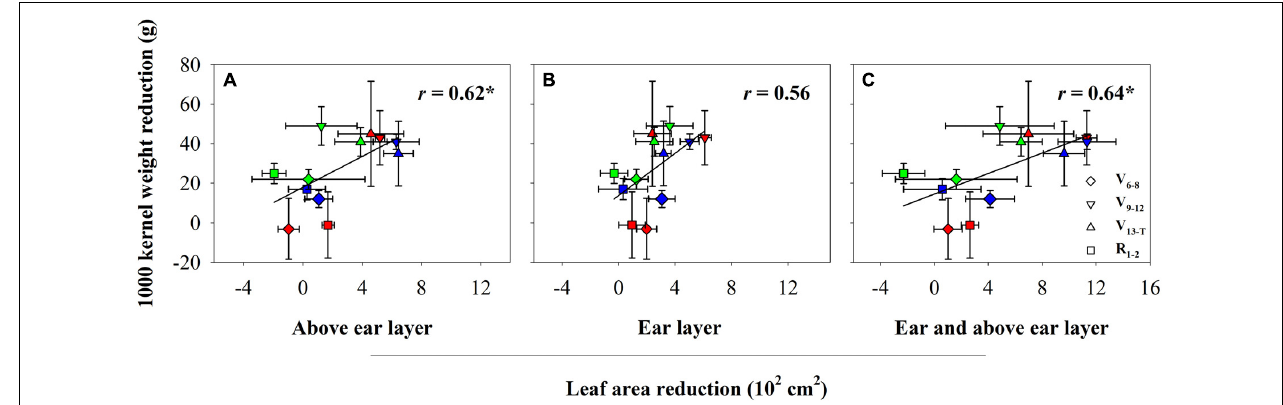
FIGURE 1 | The relationship between kernel weight and leaf area reduction at above ear layer (A) , ear layer (B) , and ear and above ear layer (C) in 2014 (red), 2015 (blue), and 2016 (green). CK, well-irrigated treatment; V 6 − 8 , water deficit during the 6–8-leaf stage; V 9 − 12 , water deficit during the 9–12-leaf stage; V 13 − T , water deficit from the 13-leaf stage to tasseling stage, R 1 − 2 , water deficit from the silking stage to blister stage. ∗ indicates significance at P < 0.05.